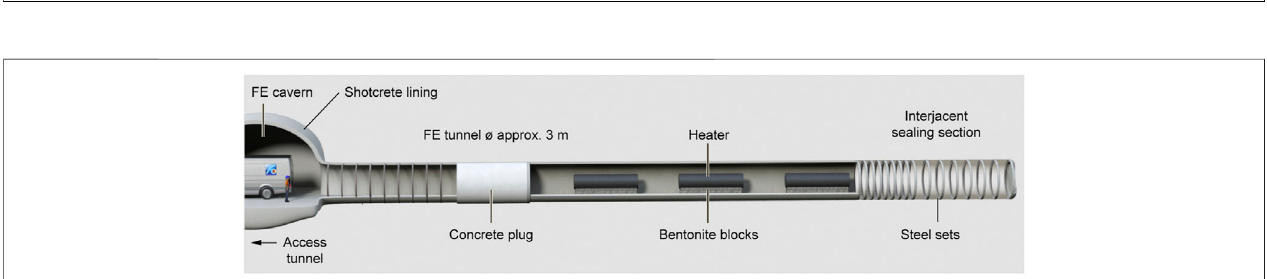
FIGURE 9 | Illustration of the Full-Scale Emplacement Experiment from Müller et al. (2017).